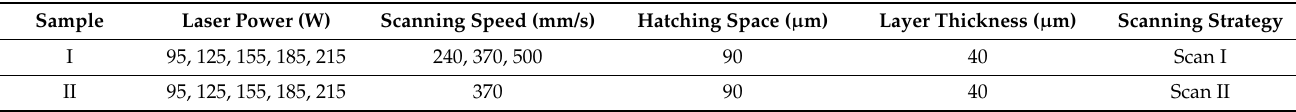
Table 2. L-PBF processing parameters of the cemented carbide